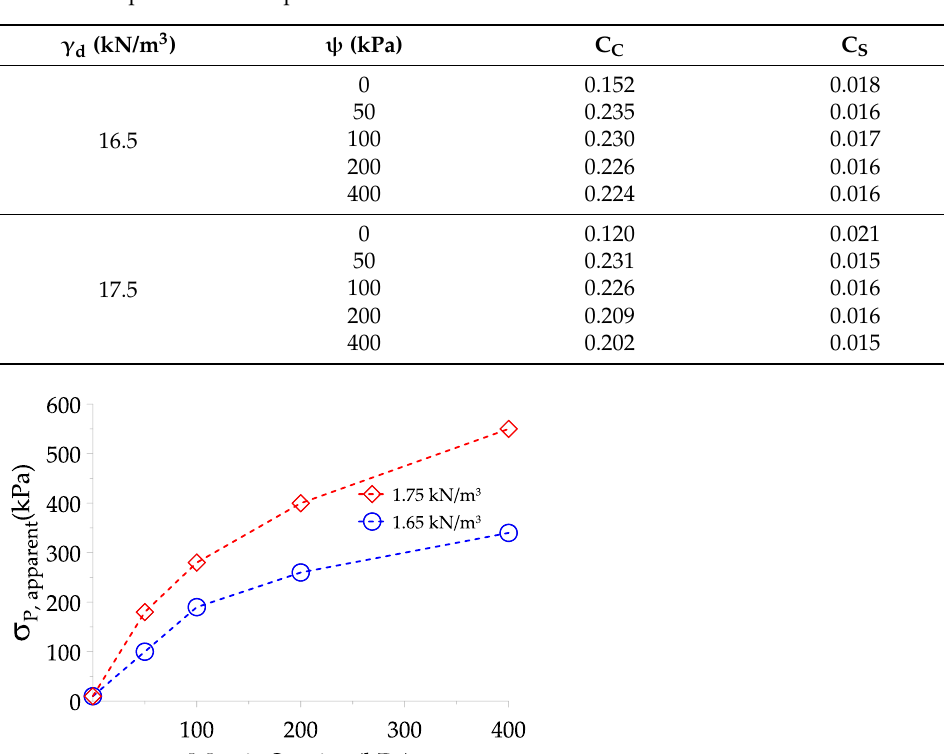
Table 7. Compression and expansion index as a function of matric suction.